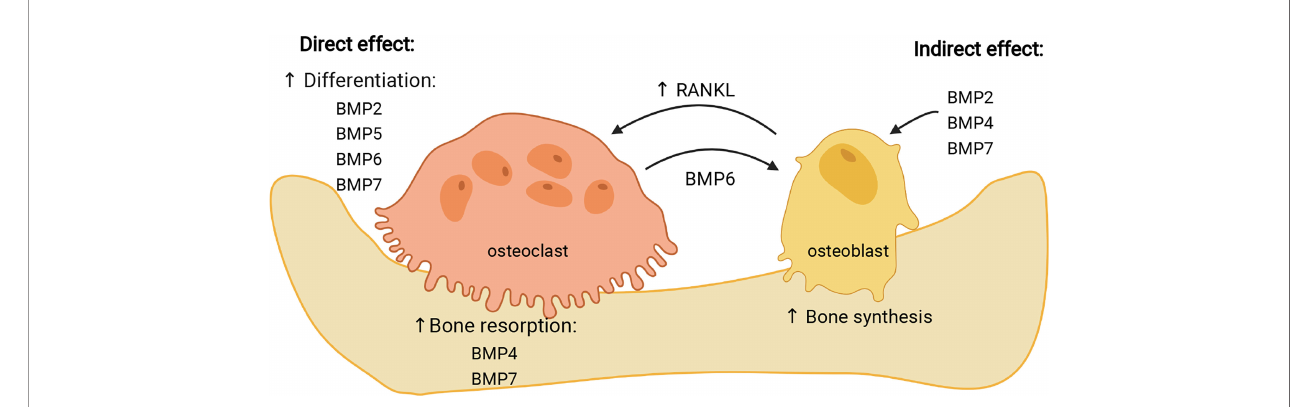
FIGURE 3 | Effects of individual BMPs on osteoclasts. BMPs can in fl uence osteoclasts either directly, stimulating their differentiation (BMP2, -5, -6, -7) and resorptive activity (BMP4, -7), or indirectly, through stimulation of osteoblasts (BMP2, -4, -7) which then increase expression of RANKL and stimulate osteoclast maturation. In addition, BMP6 expressed by osteoclasts stimulates osteogenic activity of osteoblasts. Image created by